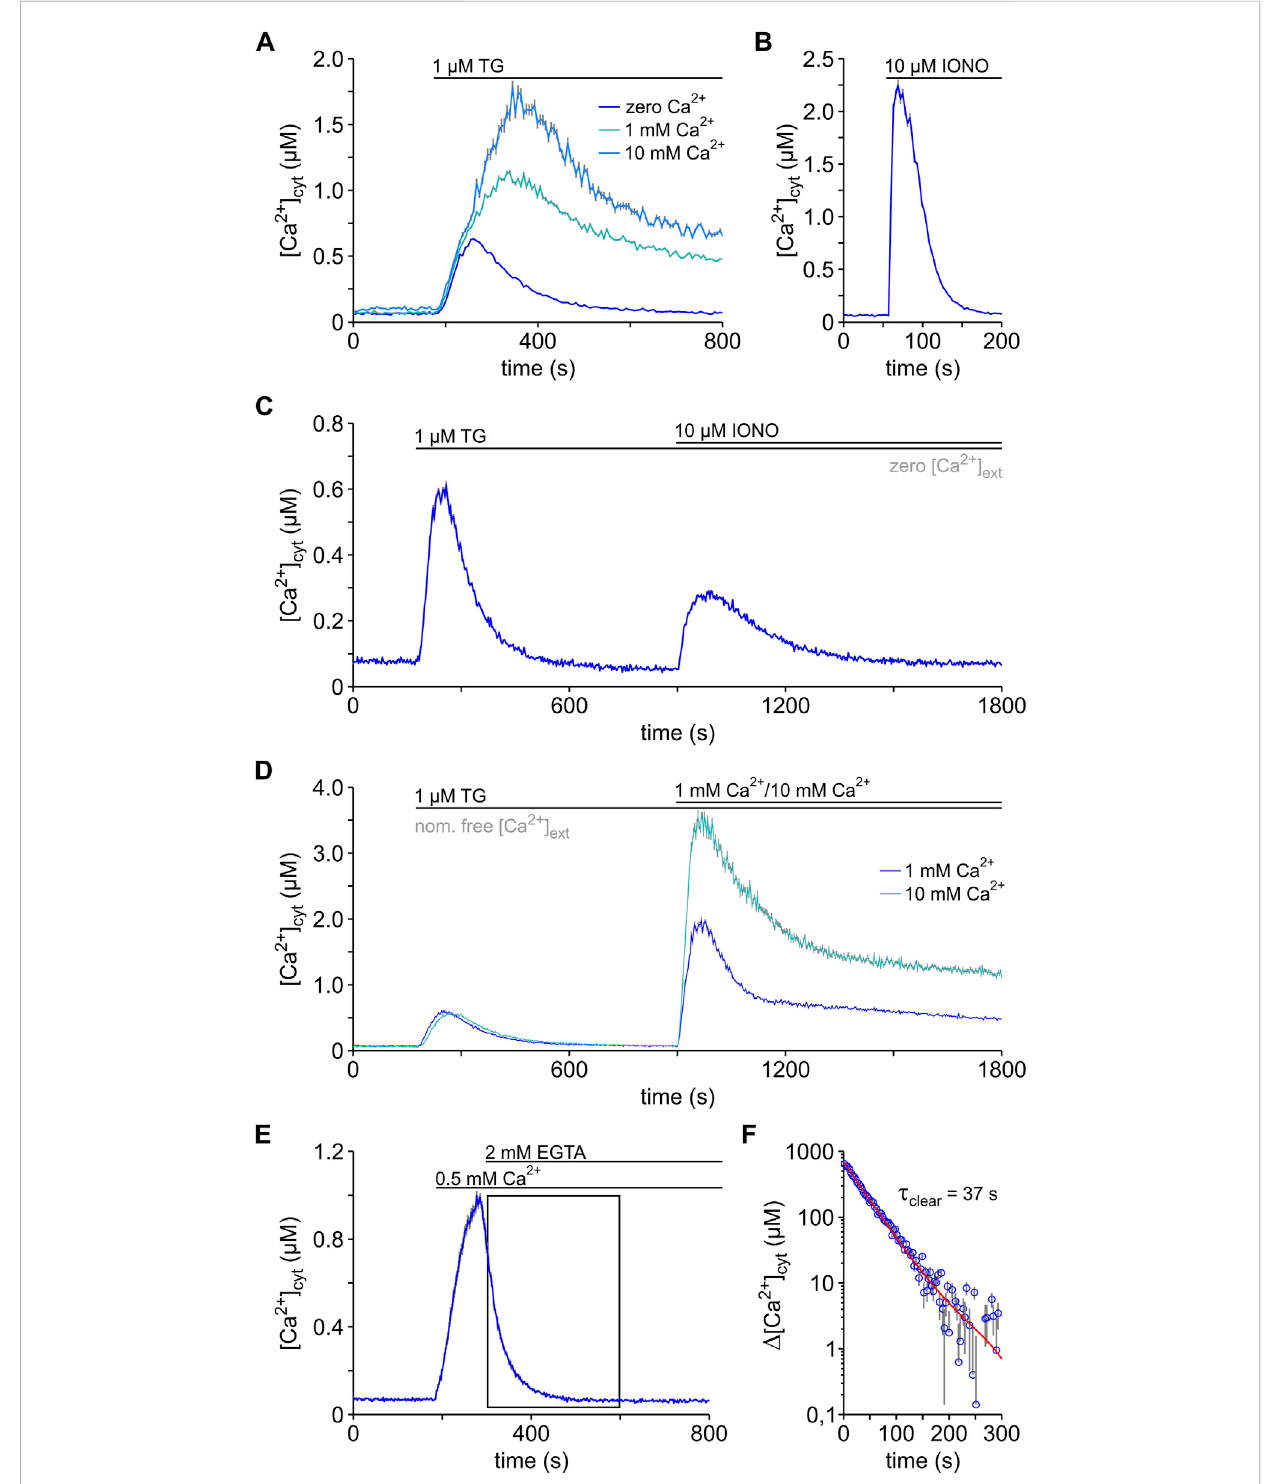
FIGURE 2 DynamicsoftheCa 2+ mobilisationinHEK-293cells.ChangesinthecytosolicCa 2+ concentration([Ca 2+ ] cyt )wereimagedusingFURA-2. (A) Ca 2+ mobilisation wasinducedbyapplyingthapsigargin(1 μ MTG) “ online ” toHEK-293cellsexposedtobathsolutionscontainingeitherzero(0.5 mMEGTA),1or10 mMfreeCa 2+ (1 mMCa 2+ ;10 mMCa 2+ ). (B) ThecontentoftotalCa 2+ inthecellswasassessedwithionomycin(10 µMIONO)intheabsenceofexternalCa 2+ ,toprevententryof externalCa 2+ . (C) ThecontentofERandnon-ERCa 2+ wasestimatedbyapplyingthapsigargin(1 μ MTG)andionomycin(10 µMIONO)sequentiallytoHEK- 293cellsintheabsenceofexternalCa 2+ (zero [Ca 2+ ] ext ). (D) Thestore-operatedCa 2+ entry(SOCE)wasanalysedusingtheso-calledCa 2+ re-additionprotocol,